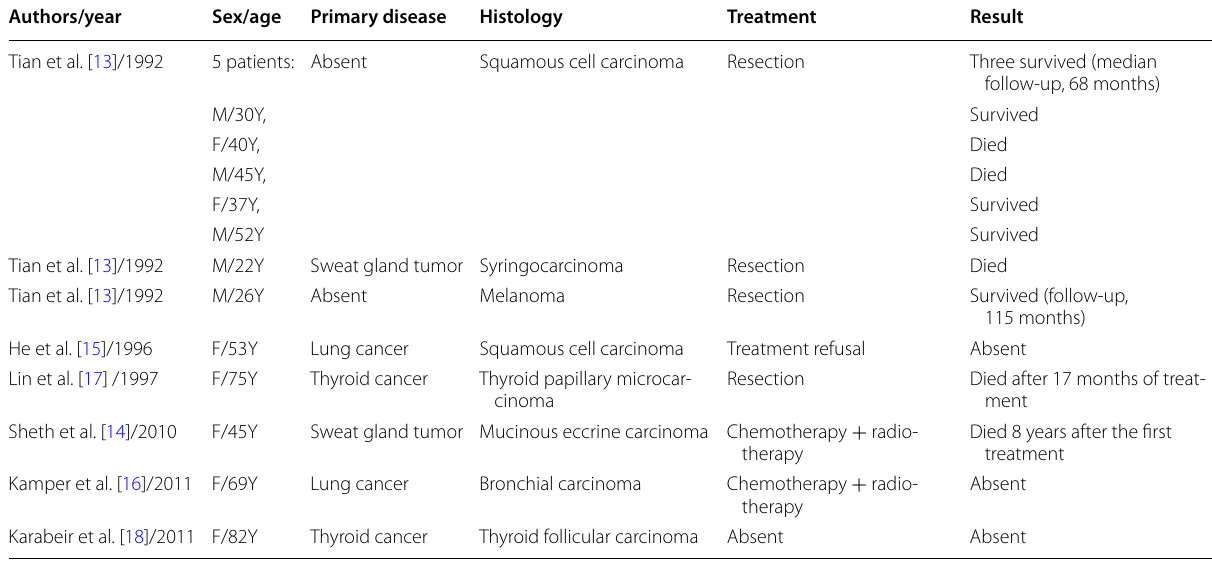
F female; M male; Y